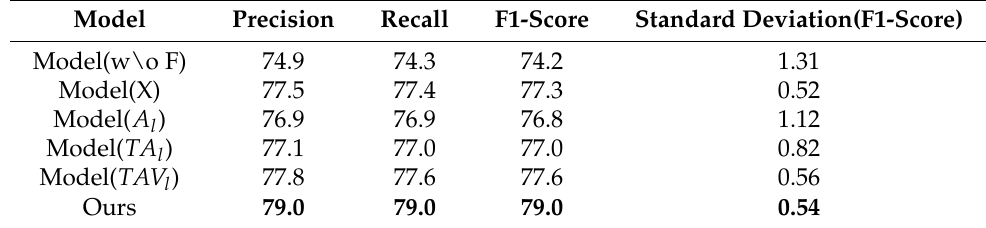
Table 7. Ablation experiment results. X represents the fixed α and β values of 0.01 and 1.0.